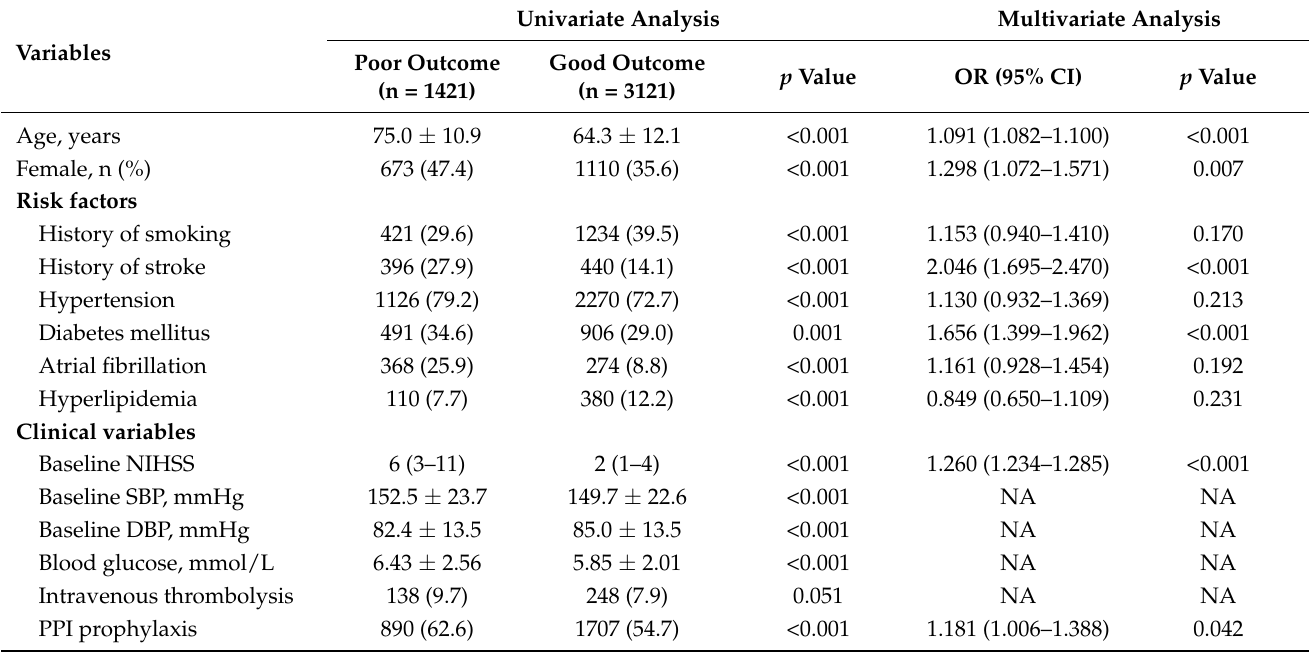
Table 3. Univariate comparison and multivariate analysis for poor outcome at one year between AIS patients with PPI prophylaxis more than seven days and less than seven